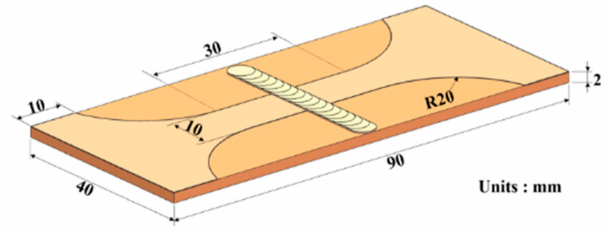
Figure 2. Dimensions of the sample for tensile test. Table 1. Three-factor and five-level orthogonal experiment for continuous LBW of